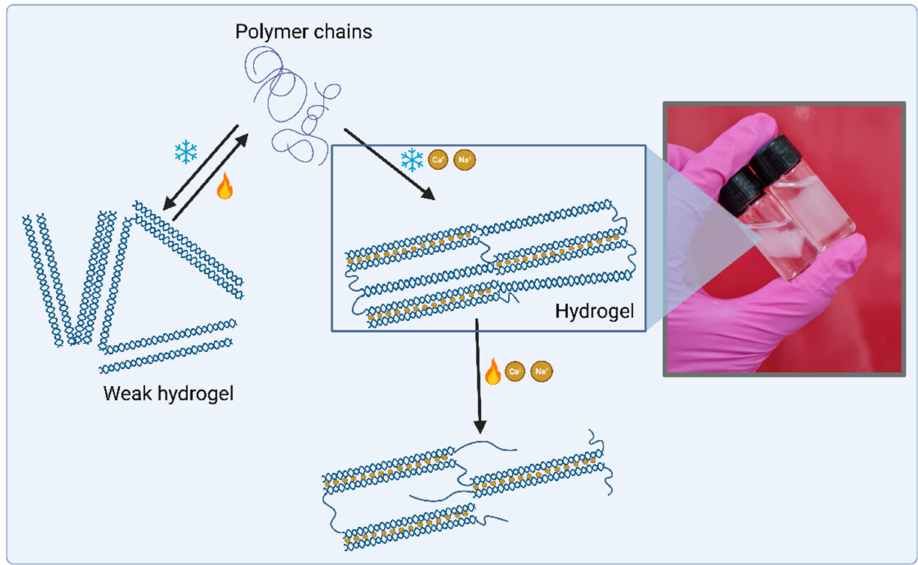
Figure 11. Gellan gum hydrogel system triggered by the presence of cations and temperature. Above 50 ◦ C, gellan gum polymer chains are disordered, but the colling process of the solution induces the formation of double helices stabled by hydrogen bonds. The presence of cations in the solution allows the interconnection of these helixes and the formation of a 3D matrix. Created with